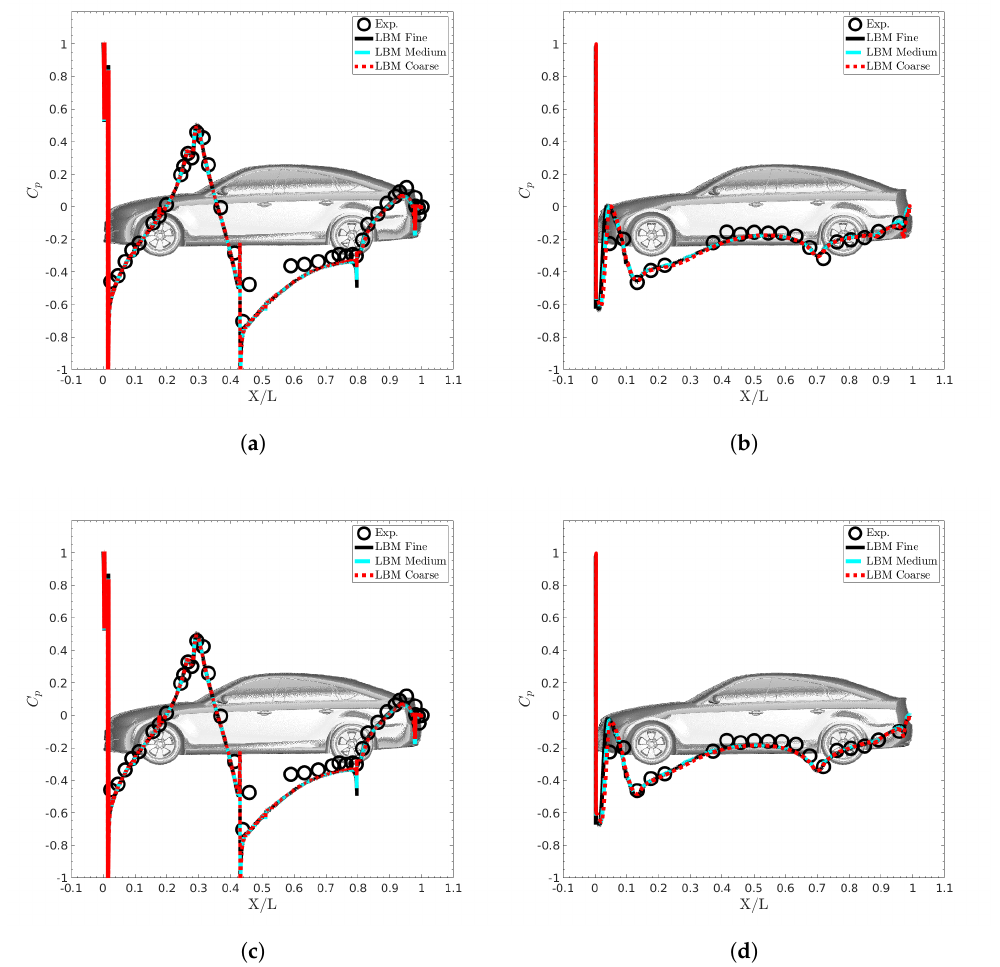
Figure 5. Comparison of the surface pressure coefficient C p on the symmetry plane of simulations with experiments [40] on the ( a ) upper surface (stationary wheels), ( b ) lower surface (stationary wheels), ( c ) upper surface (rotating wheels), ( d ) and lower surface (rotating